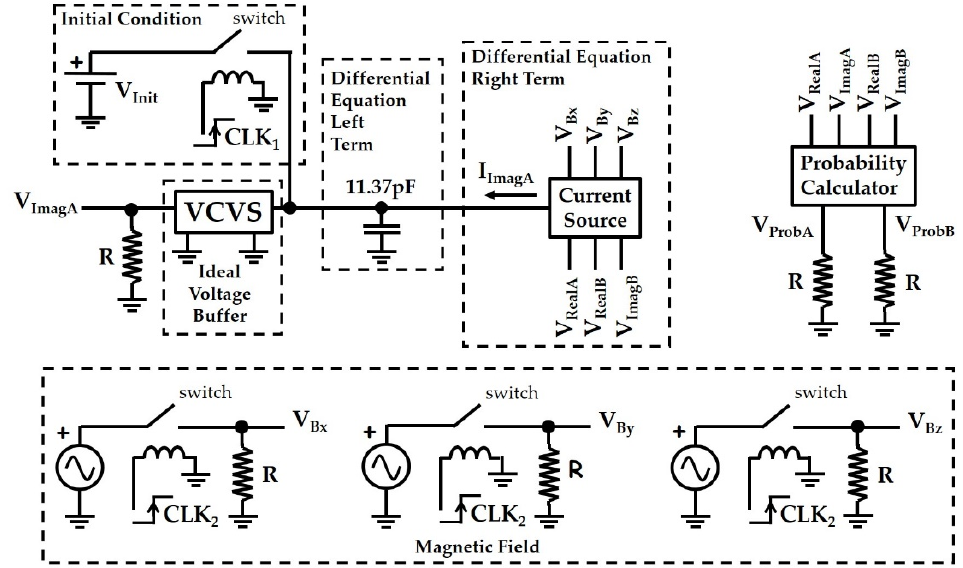
Figure 2. Implementation of the compact model in Figure 1.